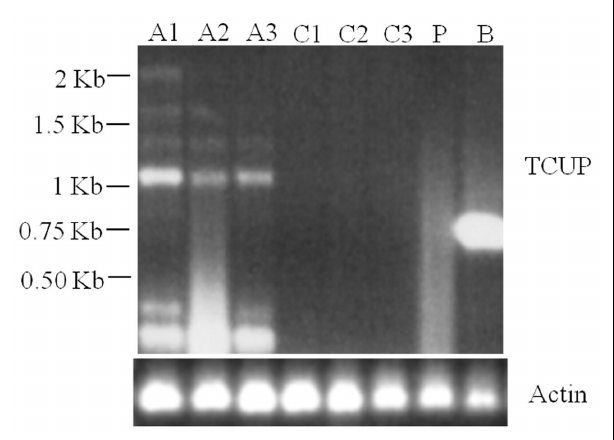
FIGURE 6 | RT-PCR demonstrating multiple TCUP transcripts present in azadC treated callus. Six separate transcripts are detected with a primer pair designed to amplify a 2.15-kb internal region of the TCUP coding sequence. Actin is shown as a control. Abbreviations: A1–A3, independent 25 μ M azadC treated Hi-II A × B tissue culture cell lines; C1–C3, independent untreated Hi-II A × B tissue culture cell lines; P, Hi-II A × B seedling; B, BMS callus.